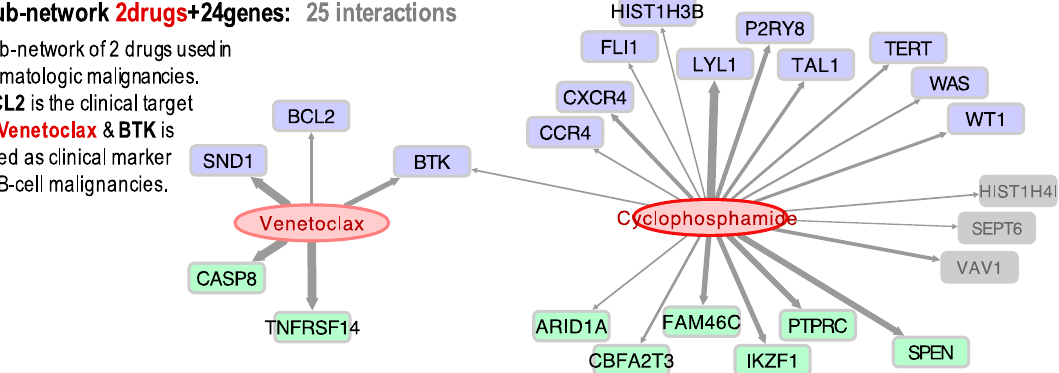
Figure 2. Bipartite directed sub-network of two cancer drugs (Venetoclax and Cyclophosphamine) and their target cancer genes: 13 oncogenes (blue); 8 tumor-suppressors (green); and 3 other cancer-related genes (grey) with an unassigned role. The links (grey arrows) show the significant correlation found between the expression profiles of the genes and the activity of the drugs, tested in cancer cell lines.